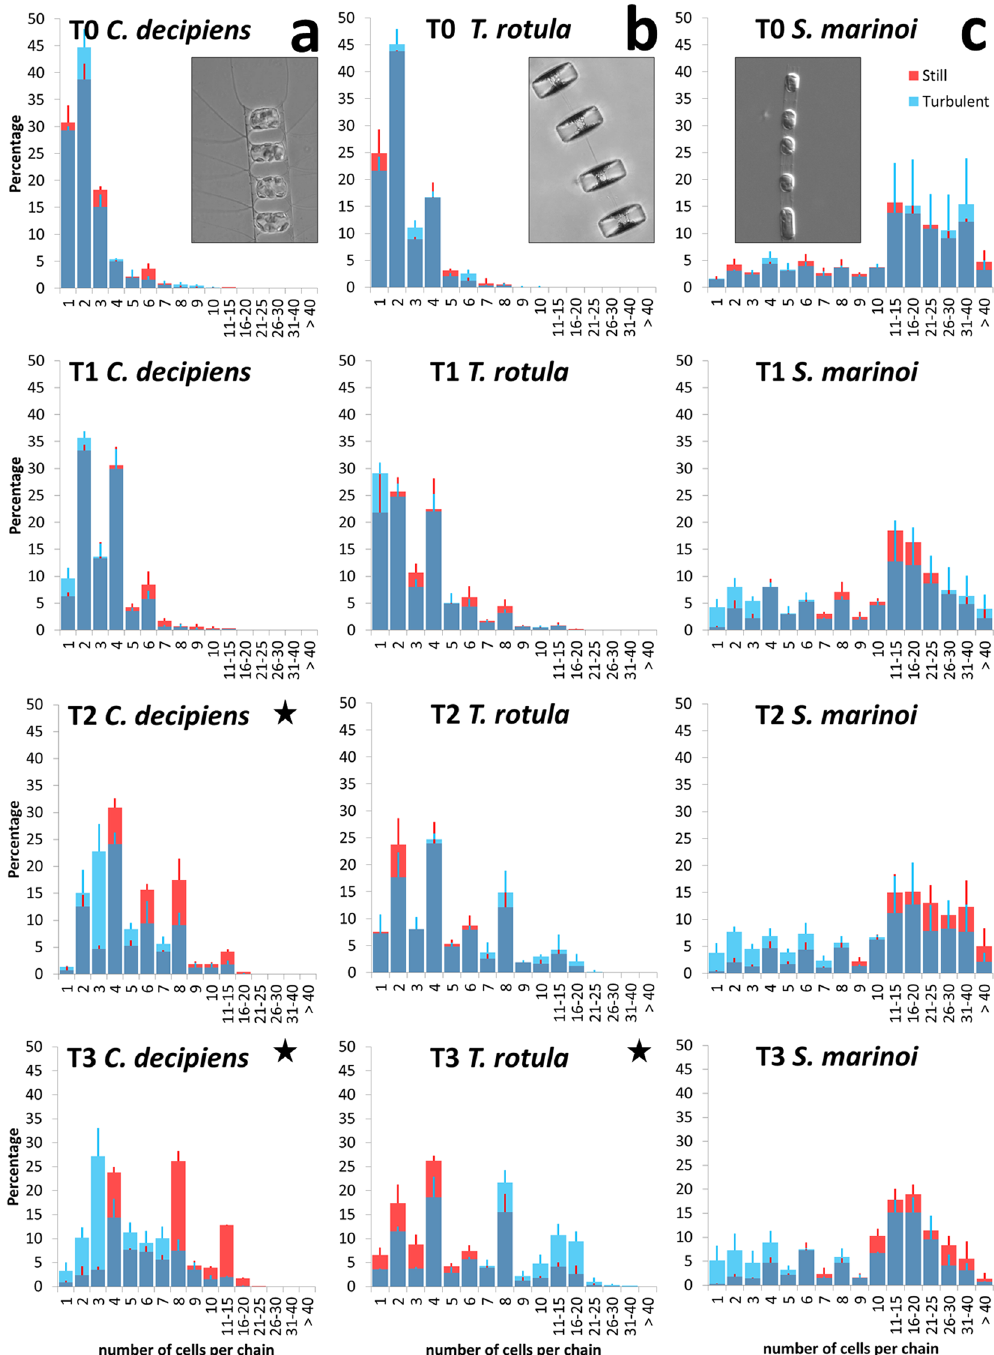
Figure 3. Chain spectra over time (T0-T3) in the three tested species. ( a ) Chaetoceros decipiens , ( b ) Thalassiosira rotula , ( c ) Skeletonema marinoi . A representative chain of each species is depicted in the inlets (courtesy of I. Percopo). On the x-axis the chain length expressed as number of cells per chain is reported, on the y-axis the frequency of each chain class expressed in percentage. Dark blue portions of the histograms indicate overlap, red histograms indicate enrichment of a given chain class in the still condition, blue histograms indicate enrichment in the turbulent condition. The reported values are average of three replicates; vertical bars indicate standard deviations (red for still and blue for turbulent conditions, respectively). All results were statistically validated by Kolmogorov-Smirnov two-sample (KS2) and Wilcoxon non parametric tests (Supplementary Tables 8 and 9), a black star indicates that test outcome equals